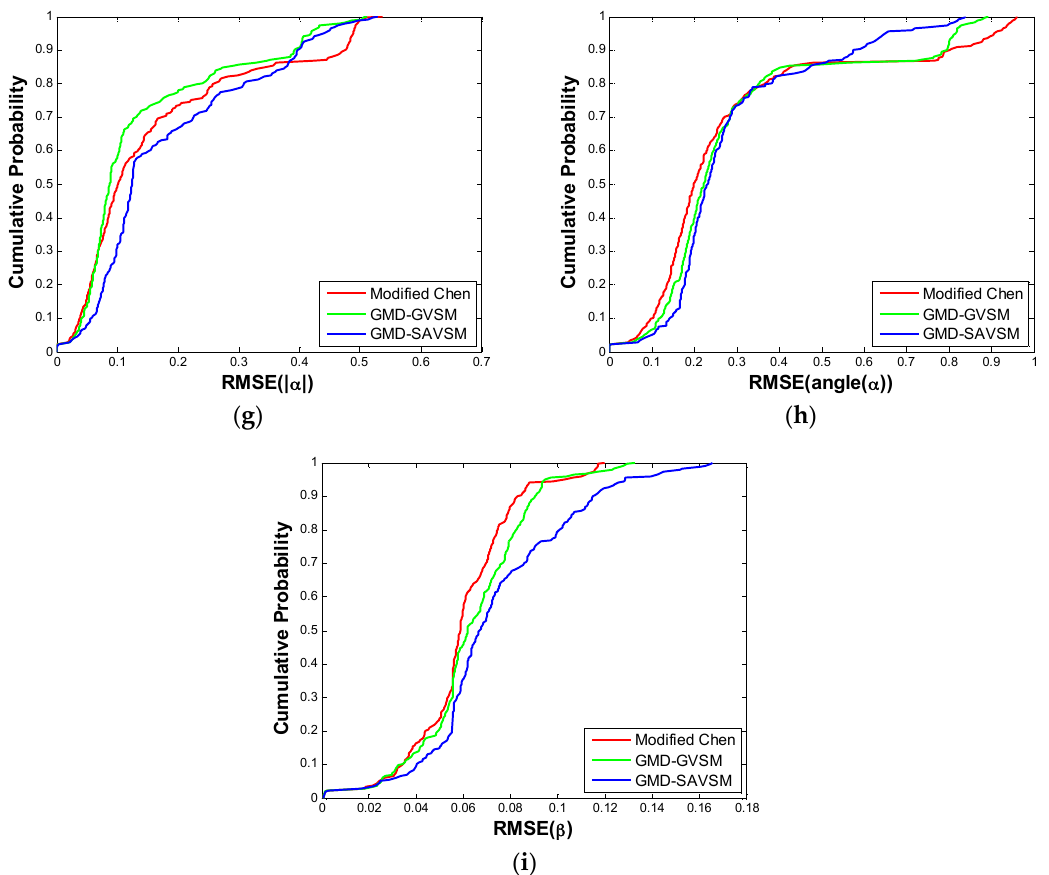
Figure 6. Cumulative probability distribution curves of root mean square error (RMSE) of all the model parameters from different methods. Red: Modified Chen, Green: General model-based decomposition (GMD)–GVSM, Blue: GMD–SAVSM. ( a ) Volume scattering coefficient; ( b ) Surface scattering coefficient; ( c ) Double-bounce scattering coefficient; ( d ) Helix scattering coefficient; ( e ) Rotation angle in surface scattering model; ( f ) Rotation angle in double-bounce scattering model; ( g ) Absolute value of double-bounce model parameter α ; ( h ) Argument of double-bounce model parameter α ; ( i ) Surface scattering model parameter β